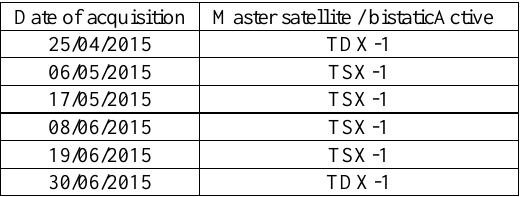
Table 2. Master satellite in bistatic pair for successive dates of acquisitions.